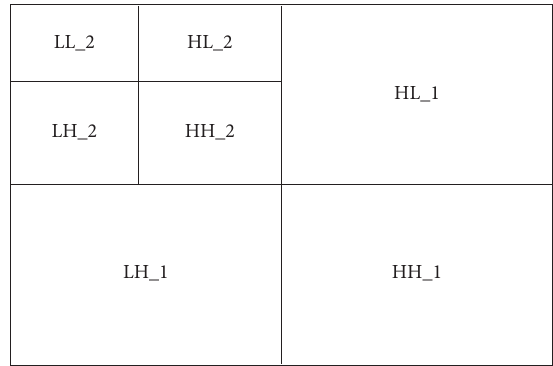
Figure 2: Decomposition diagram of second-order